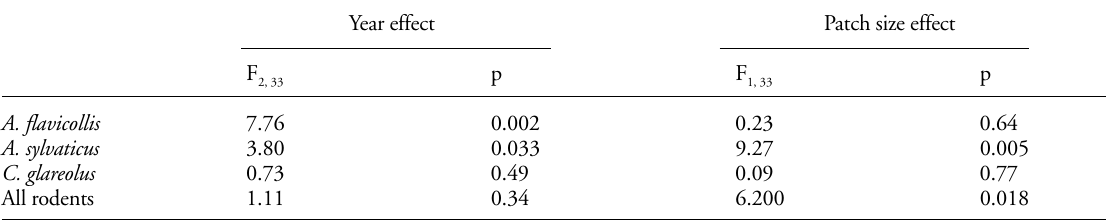
Table 1. Effect of year and patch size on rodent density indices according to two-way ANOVAs. All interactions were non significant and are not included in this